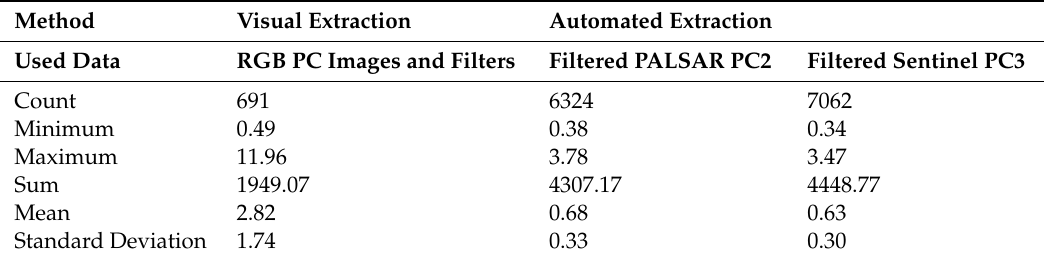
Table 6. Basic statistics of extracted lineaments from SAR